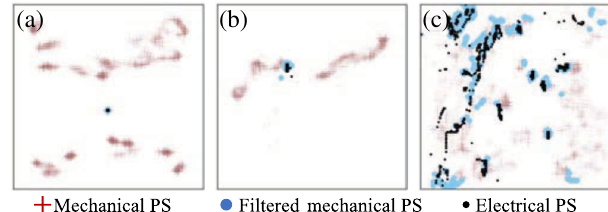
FIG. 12. Automated separation of paired (blue dots) from unpaired mechanical singularities (red crosses). Paired mechani- cal singularities colocalize with electrical singularities (black dots). The separation is performed by analyzing the temporal evolution of the strain surrounding a mechanical singularity. Phase singularities sampled over a short time interval (approx- imately 0.4 s) on the surface of 3D tissue during dynamics as shown in Figs. 9 – 11: (a) single scroll wave with fibers aligned along the x axis; (b) single scroll wave with fibers rotated by 90°; (c) scroll wave chaos with wave